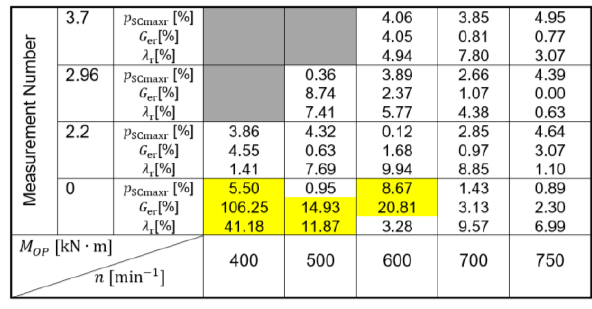
Table 2. The adequacy measure rates adopted for the engine of partial technical fitness for